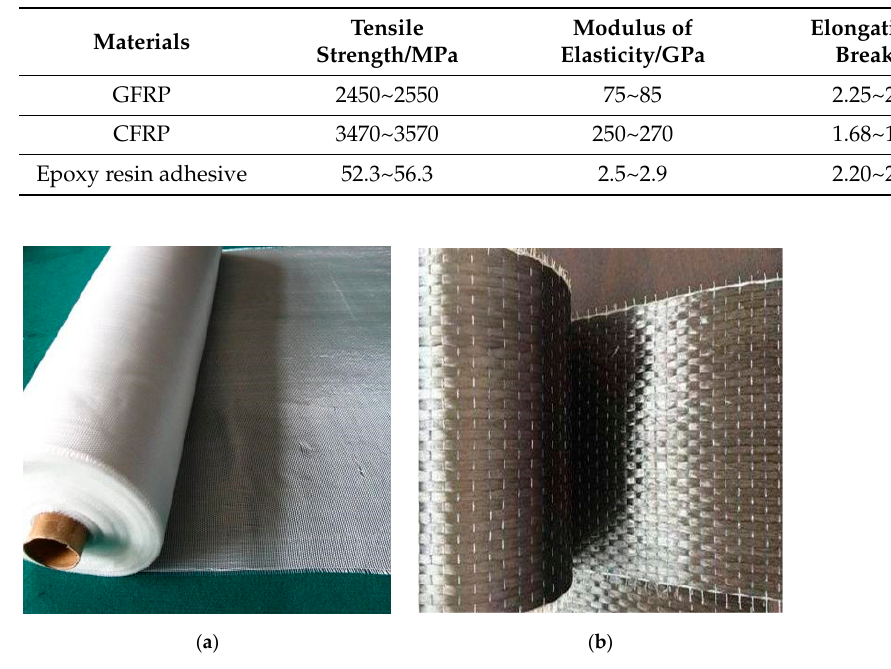
Figure 1. Fiber cloth: ( a ) glass fiber cloth; ( b ) carbon fiber cloth.